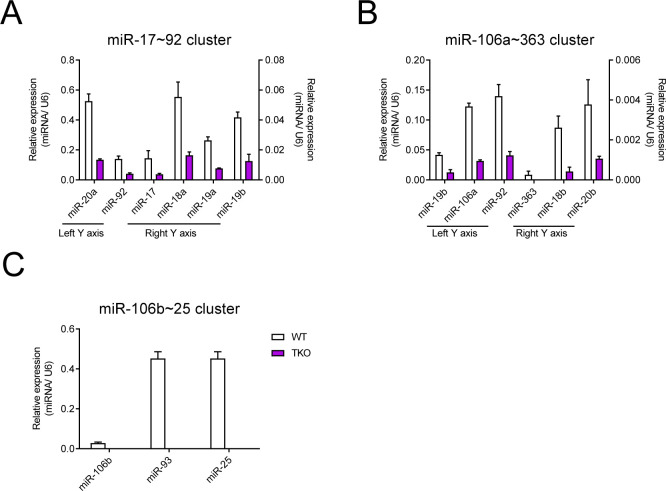
The miR-17~92 family miRNAs are efficiently deleted in TKO BMDMs.(A–C) qPCR analysis of various mature miRNAs (horizontal axes) in the miR-17~92 cluster (A), miR-106a~363 cluster (B), and miR-106b~25 cluster (C) in Lyz2-Cre (WT) and miR-106a~363−/− miR-106b~25−/− miR-17~92flox/flox
Lyz2-Cre (TKO) BMDMs; results are presented as relative expression normalized to the control small RNA U6. Data are representative of two independent experiments (mean + s.d.).